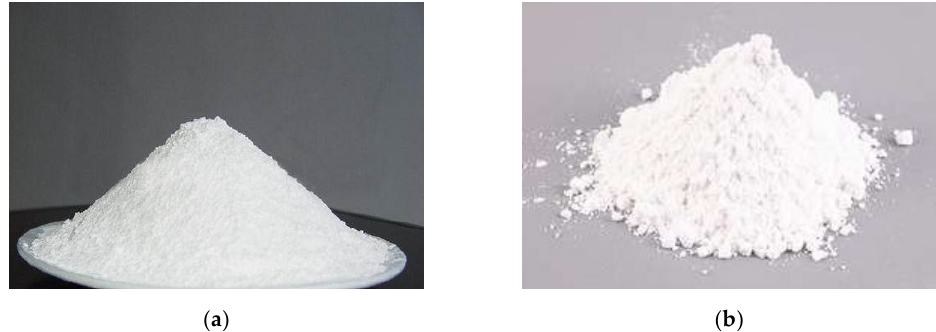
Figure 4. CA and ASE used in this study: ( a ) CaCO3 (CA); ( b ) anti-sedimentation (ASE).